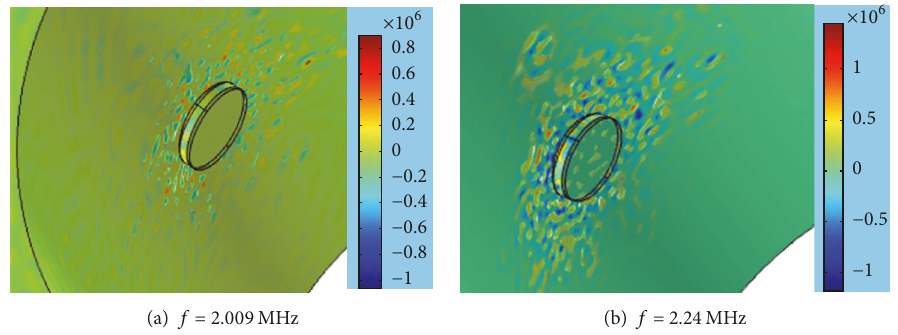
Figure 17: Acoustic pressure distributions in the cylindrical metal barrier from